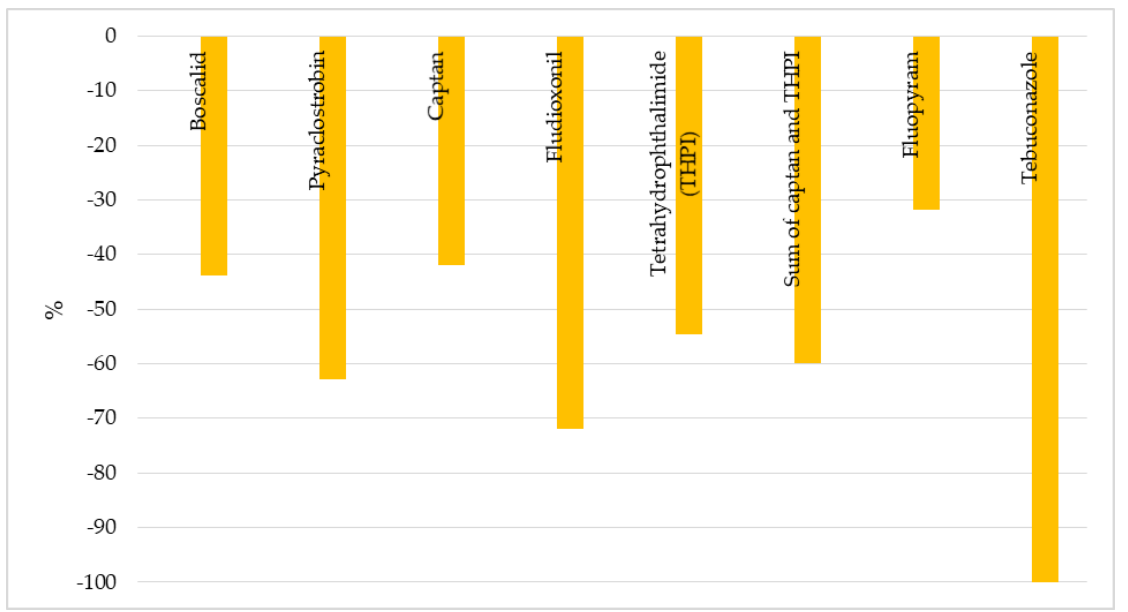
Figure 11. Percentage reduction in pesticide residues in apples as a result of peeling in 2012.